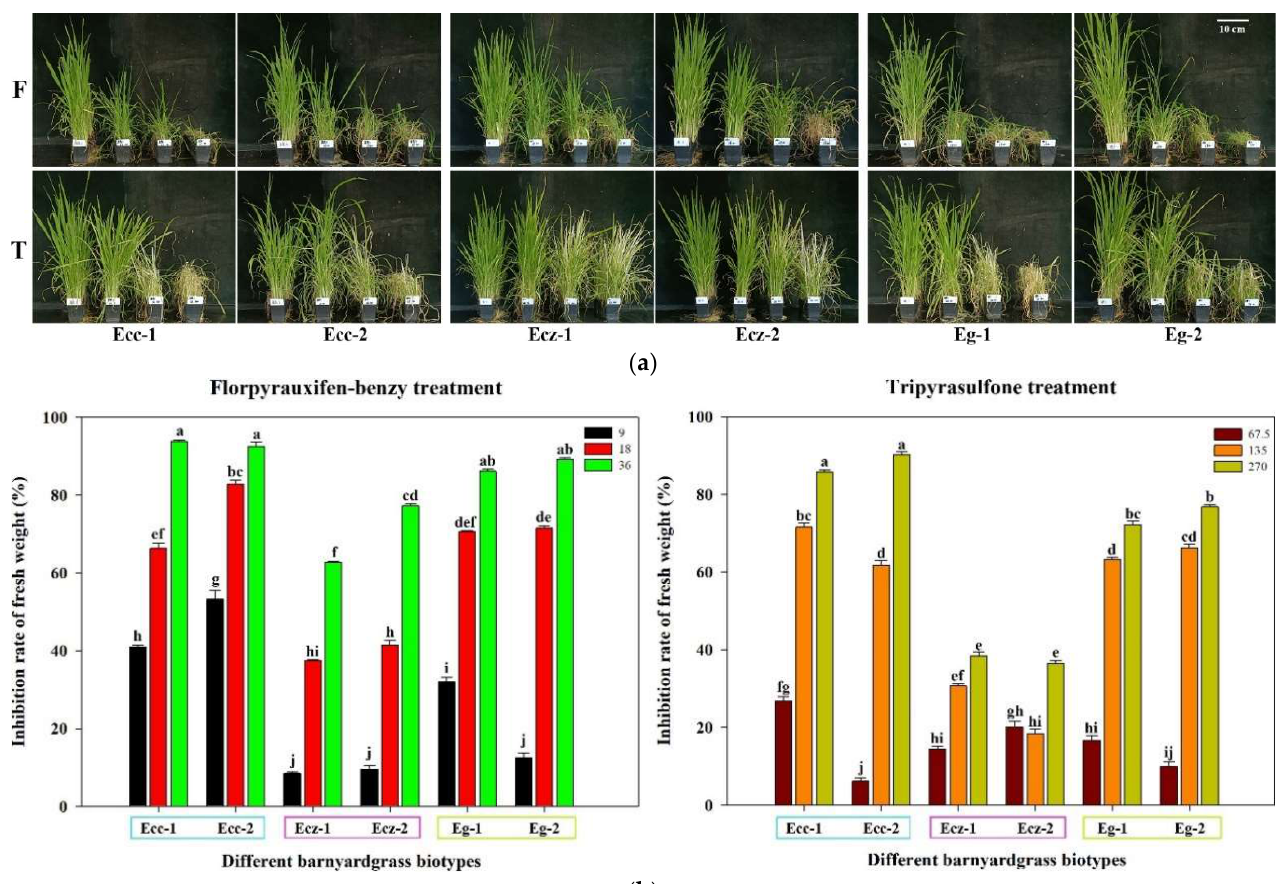
Figure 2. Differences in sensitivity to florpyrauxifen-benzyl and tripyrasulfone among E. crus-galli var. crus-galli , E. crus-galli var. zelayensis , and E. glabrescens . “F” means florpyrauxifen-benzyl treatment and the doses from left to right are 0, 9, 18, and 36 g a.i. ha –1 . “T” means tripyrasulfone treatment and the doses from left to right are 0, 67.5, 135, and 270 g a.i. ha –1 . “Ecc” means E. crus-galli var. crus-galli. “Ecz” means E. crus-galli var. zelayensis. “Eg” means E. glabrescens. ”-1” means biotype 1. ”-2” means biotype 2. ANOVA significance groupings were shown as a–j. ( a ) Differences in morphology after florpyrauxifen-benzyl and tripyrasulfone treatment. ( b ) Fresh weights of plants from each biotype at the end of equivalent treatment periods plotted as a percentage of the respective control.